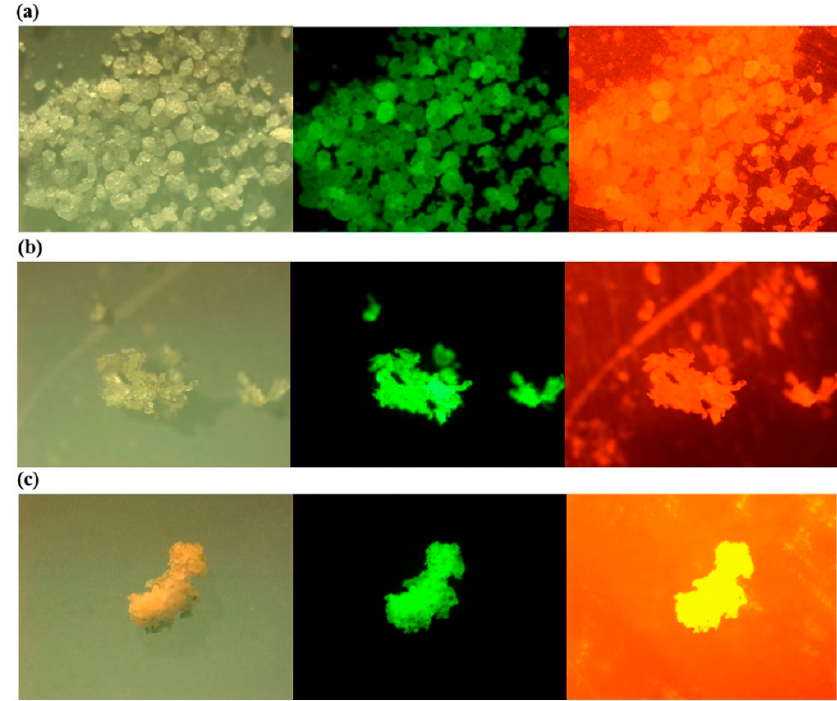
Figure 5. Photos under a microscope (left), a fluorescence microscope with excitation and emission wavelength of 534–558 and 515–565 nm (middle); and 534–558 and >590 nm (right) for the Nile Red stained low density ( a ) polyethylene (LDPE); ( b ) polypropylene (PP); ( c ) expanded polystyrene (EPS) [93]. Reprinted from Marine Pollution Bulletin , 113, Shim, W.J.; Song, Y.K.; Hong, S.H.; Jang, M., Identification and Quantification of Microplastics Using Nile Red Staining, 469–476. [93], Copyright (2016), with permission from